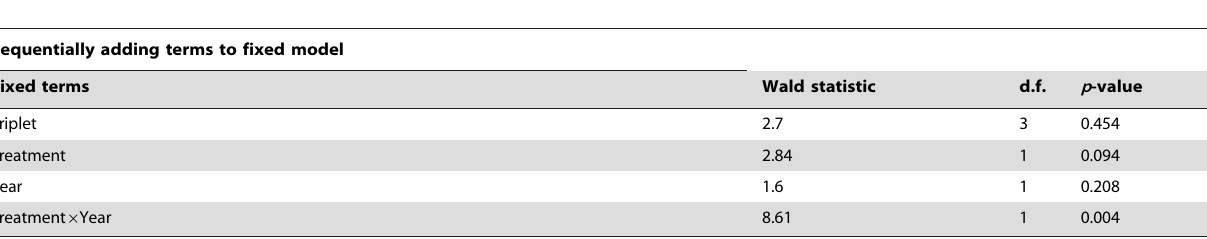
Table 2. Summarised results of GLMM explaining variance in annual counts of hedgehogs on amenity grassland in relation to experimental badger culling.